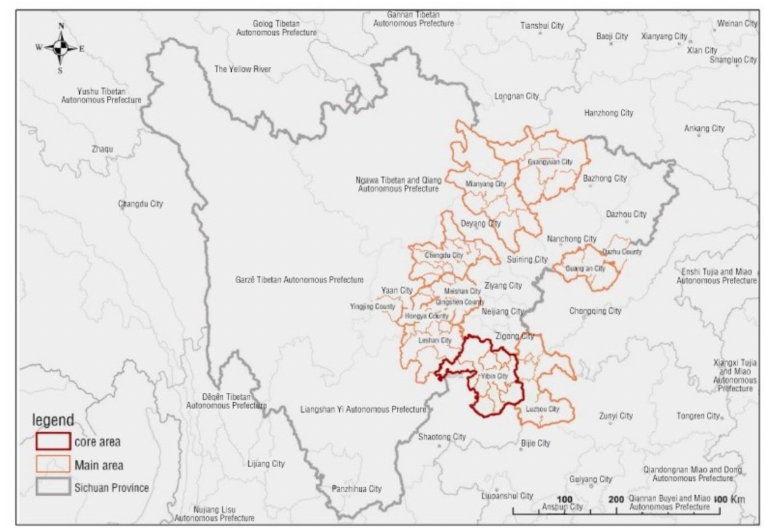
Figure 3. Distribution of research areas of bamboo scenic lines in Sichuan Province.